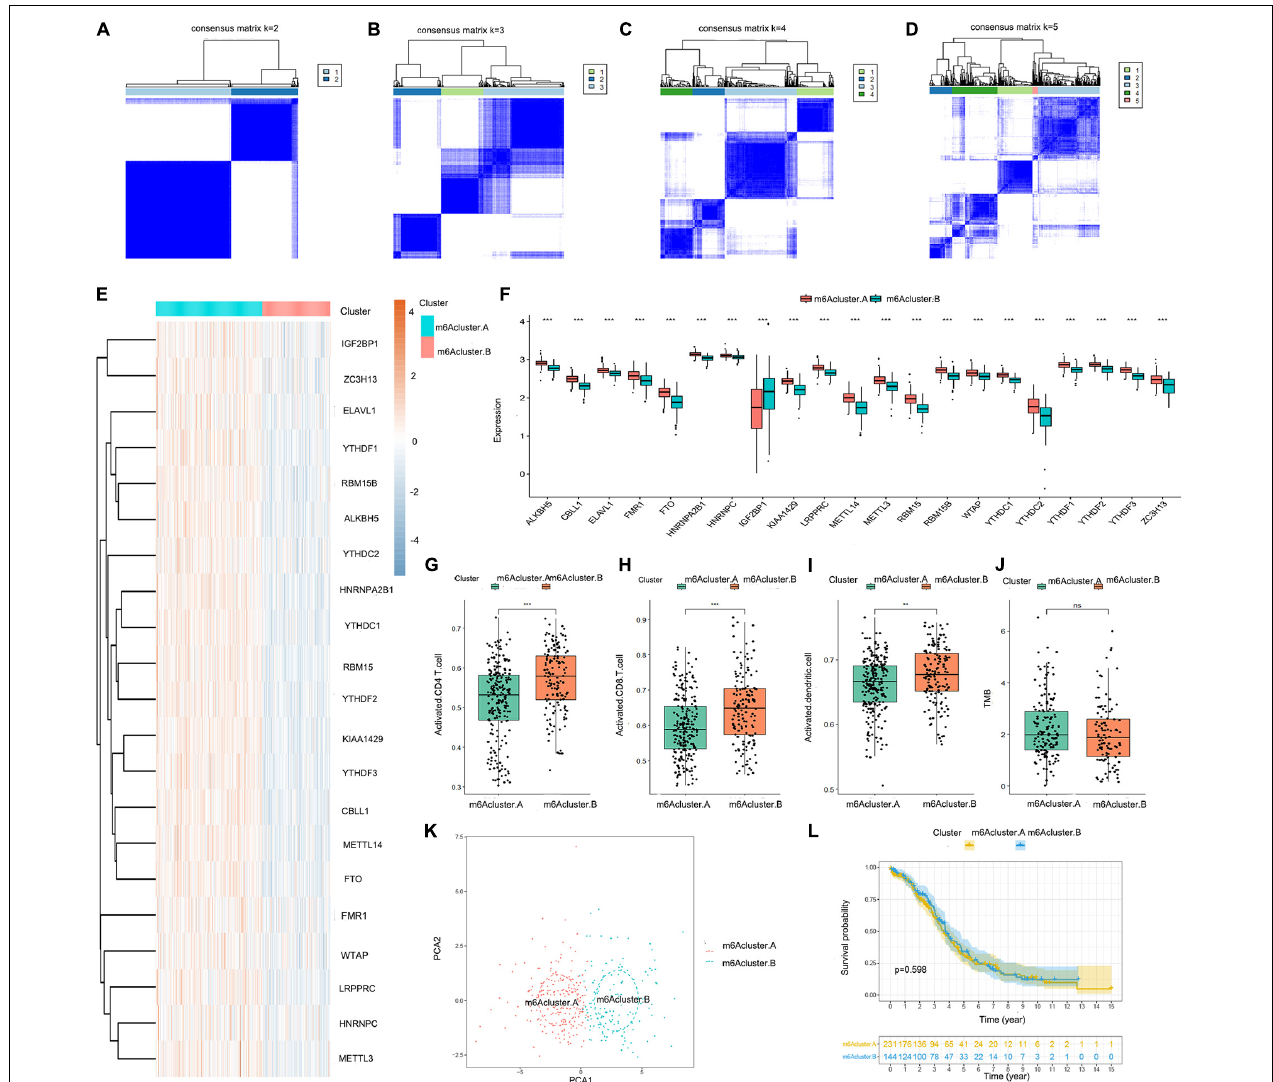
FIGURE 2 | Consensus clustering of the 21 m6A regulators in TCGA-OV dataset. (A–D) Consensus matrices of the 21 m6A regulators for k = 2–5. (E) Expression heat map of the 21 m6A regulators in m6Acluster.A and m6Acluster.B. (F) Differential expression boxplot of the 21 m6A regulators in m6Acluster.A and m6Acluster.B. Differences in the abundance of activated CD4 T cell (G) , CD8 T cell (H) , and dendritic cell (I) infiltrates between m6Acluster.A and m6Acluster.B. (J) Differences in the tumor mutation burden (TMB) level between m6Acluster.A and m6Acluster.B. (K) Principal component analysis (PCA) for the expression profiles of the 21 m6A regulators, showing a remarkable difference in transcriptomes between the 2 m6A patterns. The variance of PCA1 was 39.67, while the variance of PCA2 was 19.92. (L) Kaplan-Meier curves showing the prognostic value of the two m6A patterns in TCGA-OV dataset (** P < 0.01 and *** P <